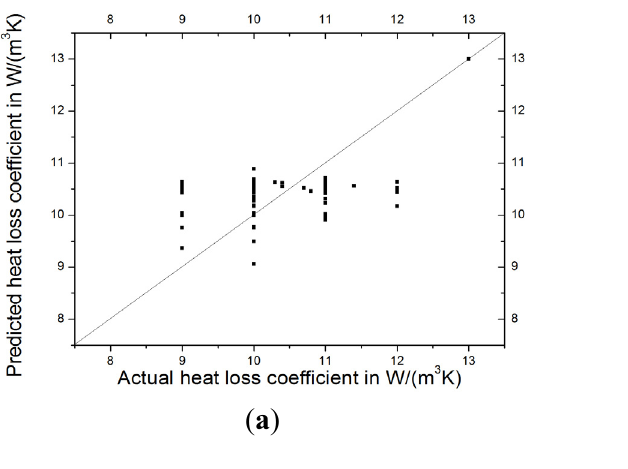
Figure 8. Training results of 778 samples using the GRNN for the prediction of heat loss coefficient. ( a ) Predicted values versus actual values; ( b ) residual values versus actual values; ( c ) residual values versus predicted